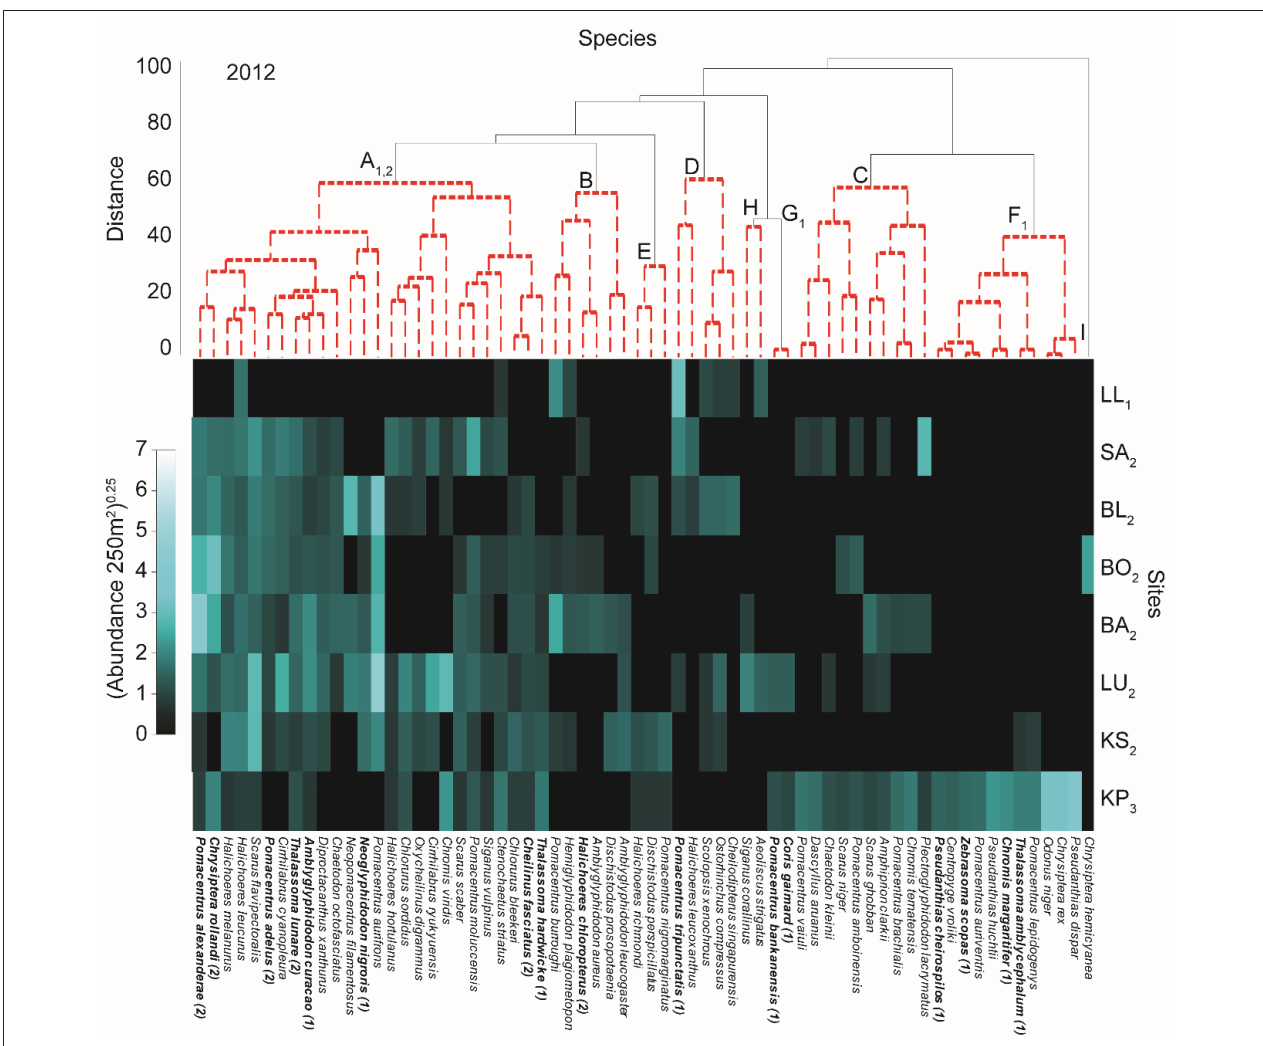
FIGURE 2 | Shade plot of relative species abundances in 2012. Results of cluster analysis showing significant groups (SIMPROF test) of species (capital lettering on species dendrogram and indicated with red dotted line) and sites (numbered subscript on site acronyms and identified in Supplementary Figure 1) with relative abundance of fish indicated in the shade plot. Sites are ordered from top to bottom increasing in distance from the mainland ( Figure 1 ). Subscript on species groups indicates a significant relationship with PCs of the benthic PCA (Supplementary Figure 3) as evaluated by multivariate GLM (Supplementary Table 2). Bolded species names indicate a specie that is related to at least one of the two (indicated in parentheses after specie name) benthic PCs. Full results for individual species can be found in Supplementary Table 1.